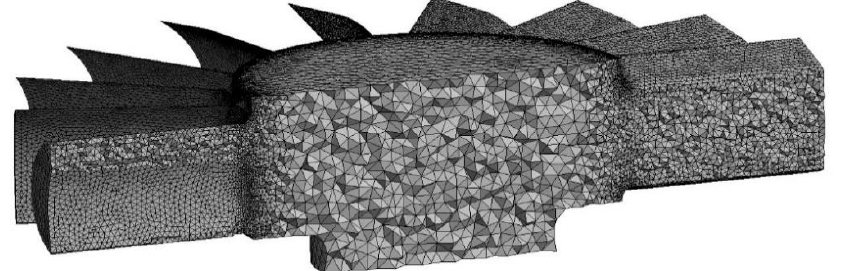
Figure 41. Axial rotor mesh section view.